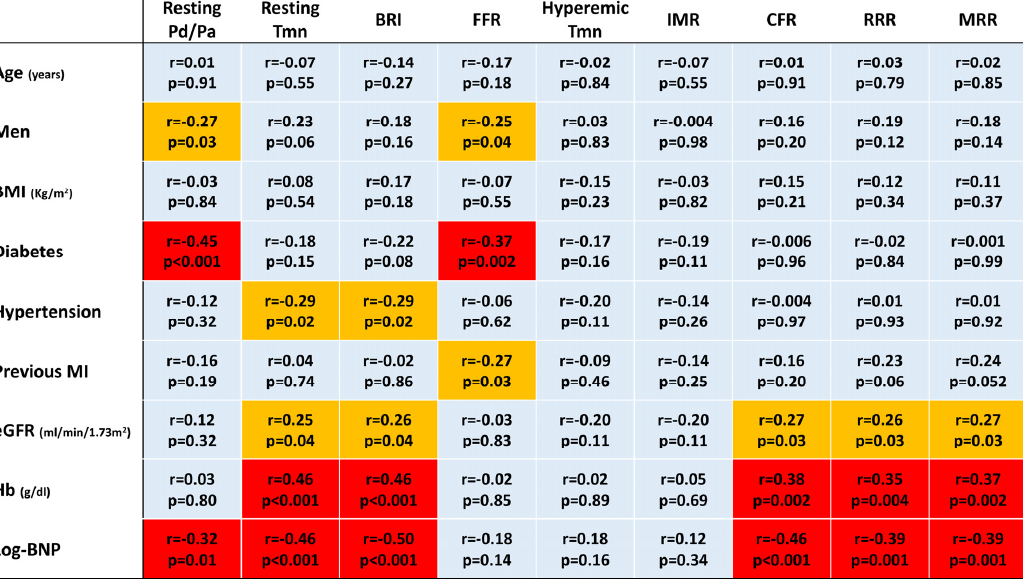
Figure 6. A heat map for univariable linear regression analyses in cases in which papaverine was used as a hyperemic agent. A cell in light blue indicates no significant association ( p ≥ 0.05). When significant associations are found ( p < 0.05), cells are displayed in light ( − 0.20 ≤ r ≤ 0.20) or warm yellow ( − 0.30 ≤ r < − 0.20 or 0.20< r ≤ 0.30) or red ( r < − 0.30 or r > 0.30). BMI, body mass index; BNP,